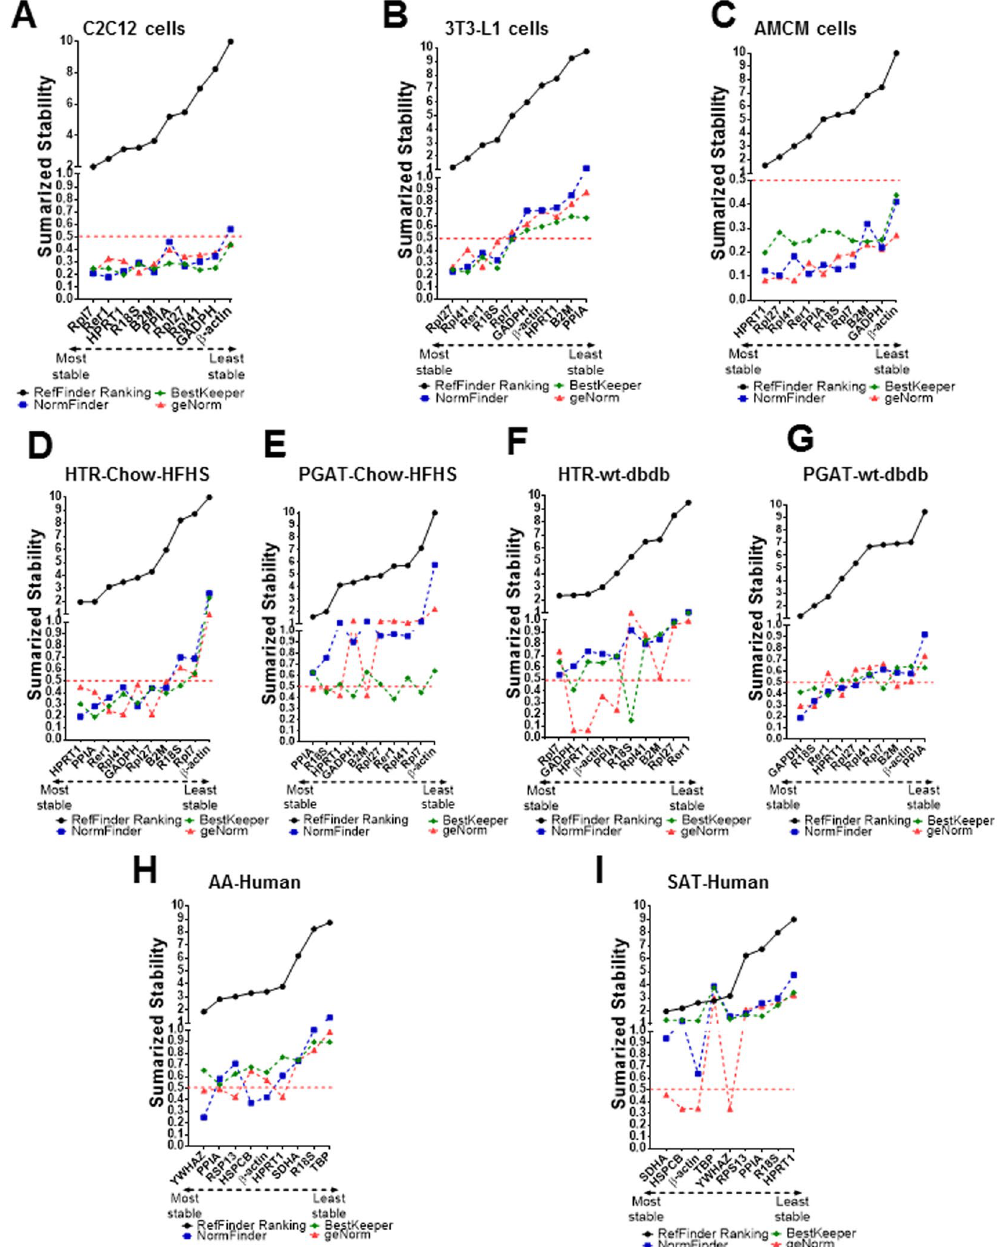
Figure 2. Summarized gene stability rankings. Gene stability ranking for C2C12 cells ( A ), 3T3-L1 cells ( B ), AMCMs ( C ), HRT ( D ) and PGAT ( E ) from chow/HFHS-fed mice, HRT ( F ) and PGAT ( G ) from WT/dbdb mice, and human AA ( H ) and SAT ( I ). For geNorm analysis the cut-off value of M < 0.5 is denoted as dashed line. Lower ranking indicates higher